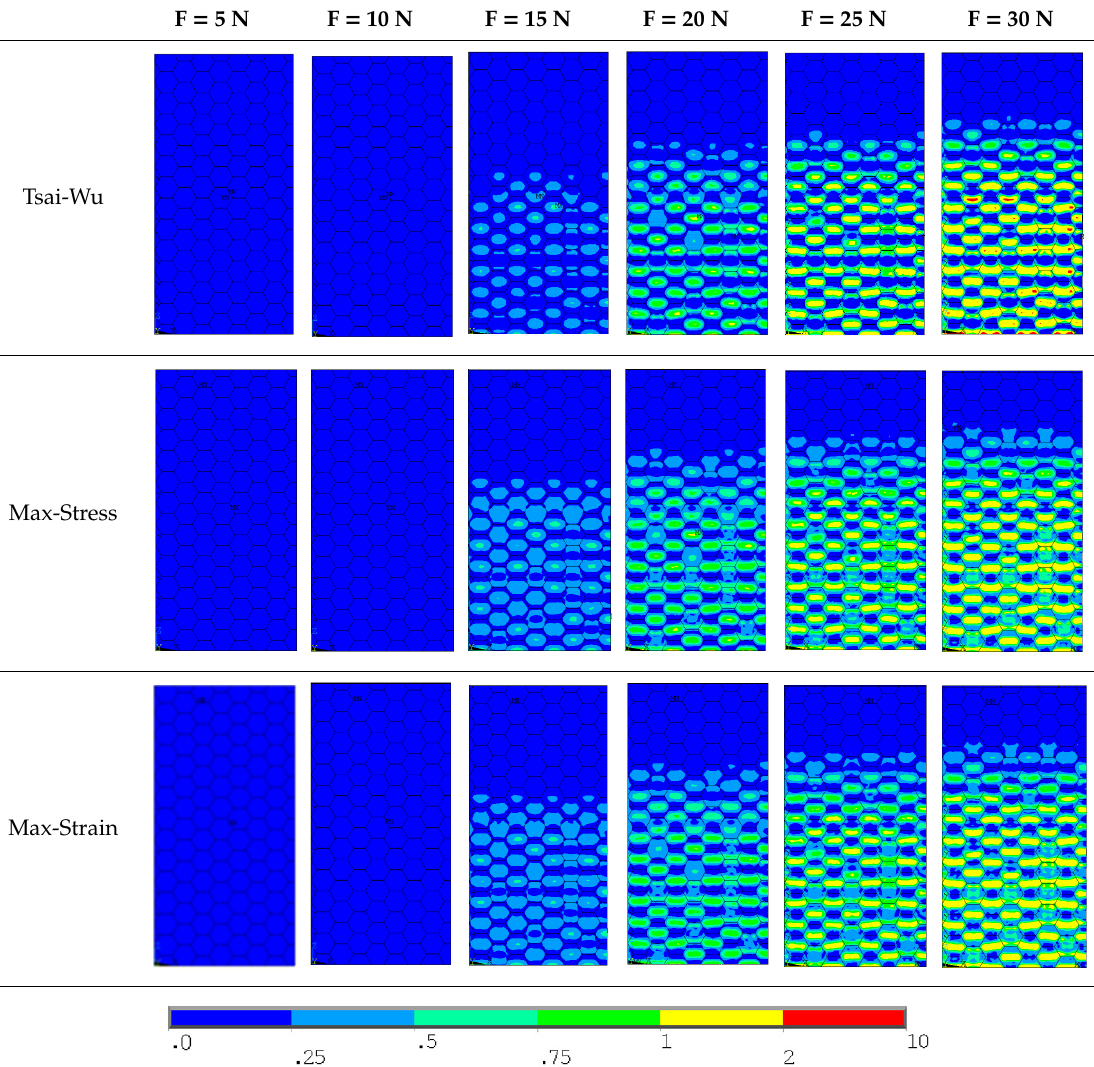
Table 7. Maps of the criteria index for Model 1.2 MD.